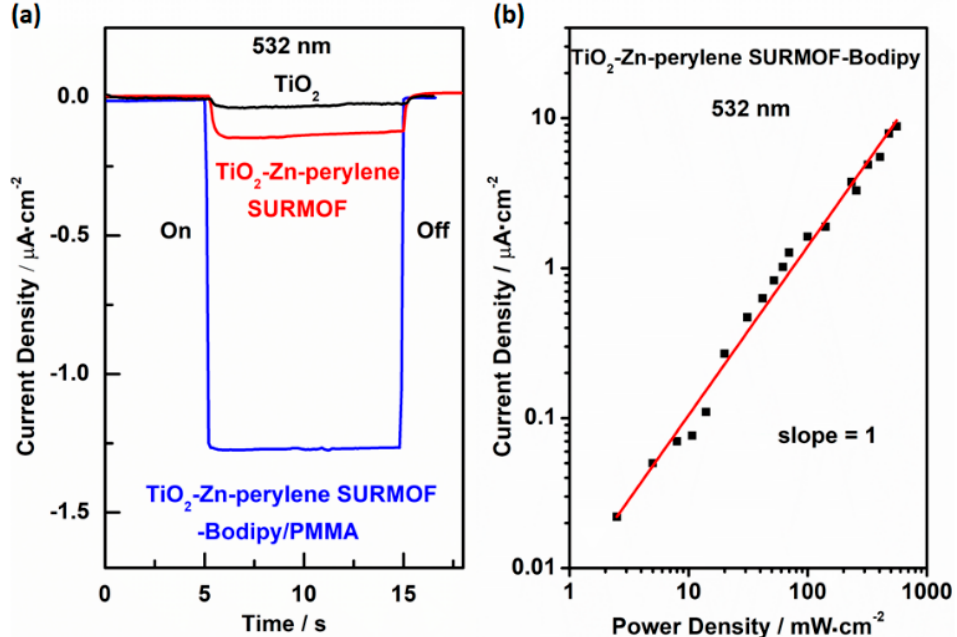
Figure 4. ( a ) The i-t curves for DSSCs composed of TiO 2 -Zn-perylene SURMOF-Bodipy/PMMA, TiO 2 -Zn-perylene SURMOF, and TiO 2 as photoanodes and Co(bpy) 32+/3+ as redox mediator under the 532 nm light irradiation (power: ~80 mW · cm − 2 ). ( b ) The current density of TiO 2 -Zn-perylene SURMOF-Bodipy/PMMA under 532 nm green light irradiation with different power intensity.